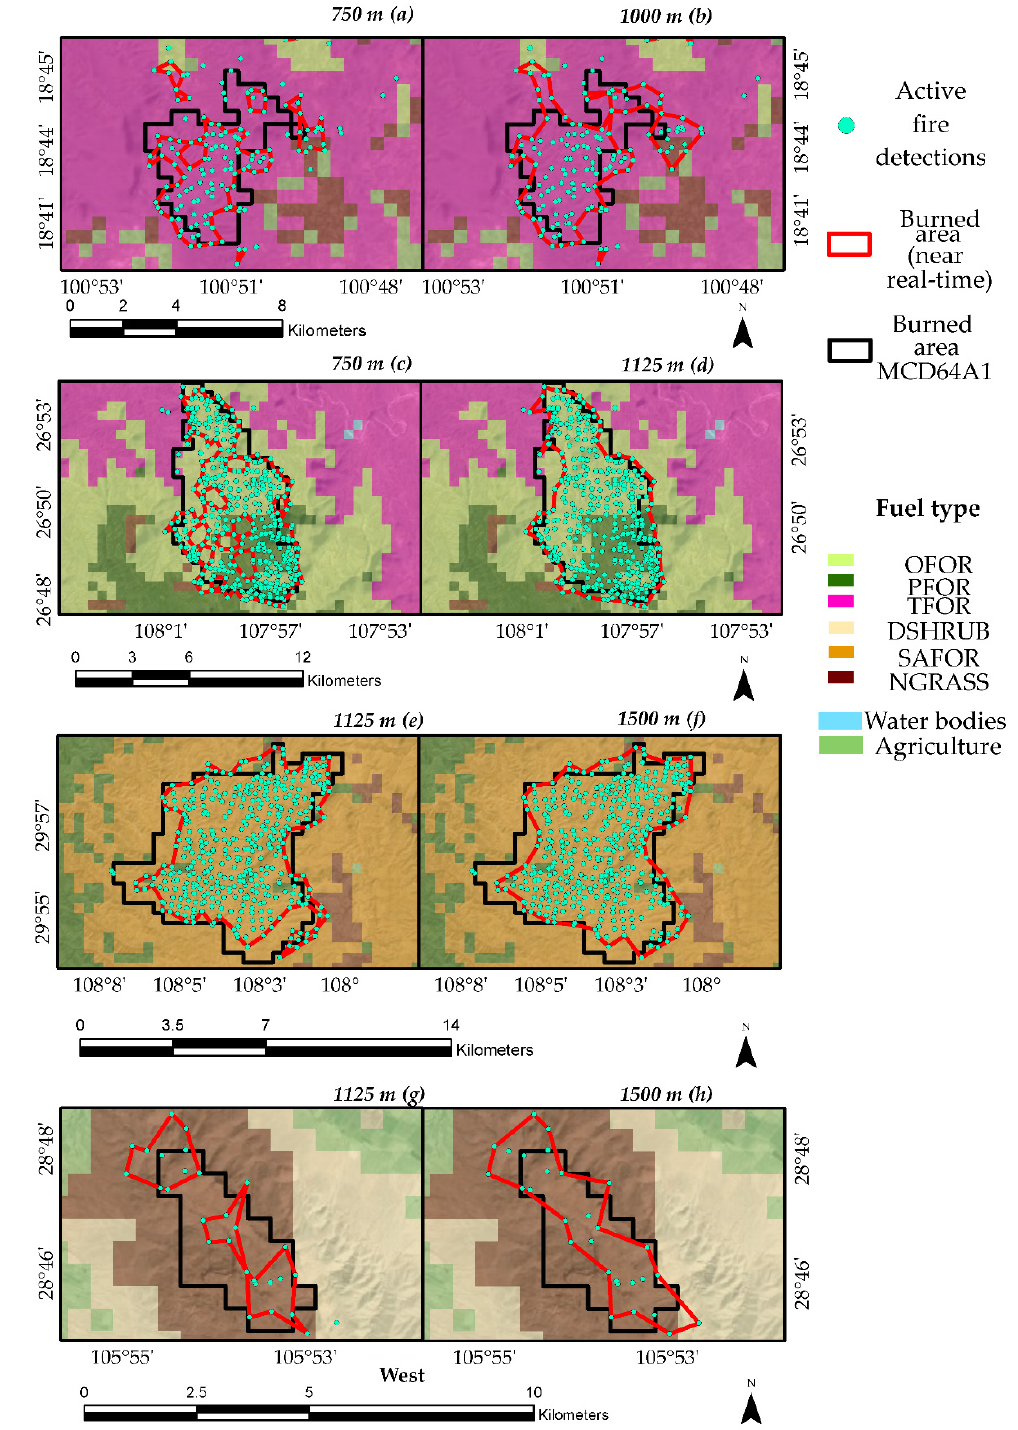
Figure 4. Examples of selected fire perimeters from April 2017 and May 2018 mapped using aggregated MODIS and VIIRS active fire data and MCD64A1 burned area, for tropical forest of the C region ( a , b ), oak forest of NW region ( c , d ), semiarid forest of the NW region ( e , f ), and grasslands of the NC region ( g , h ) at aggregation distances of 750 m ( a , c ), 1000 m ( b ), 1125 m ( d , e ), and 1500 m ( f , h ). MCD64A1 burned areas are represented in black, aggregated MODIS and VIIRS active fire perimeters are represented in red. Active fire detections are represented in bright blue. Background colors represent fuel types (Figure 1). Water bodies are shown in navy blue and agriculture in green, based on the most recent land-use map (INEGI, 2014) [25].